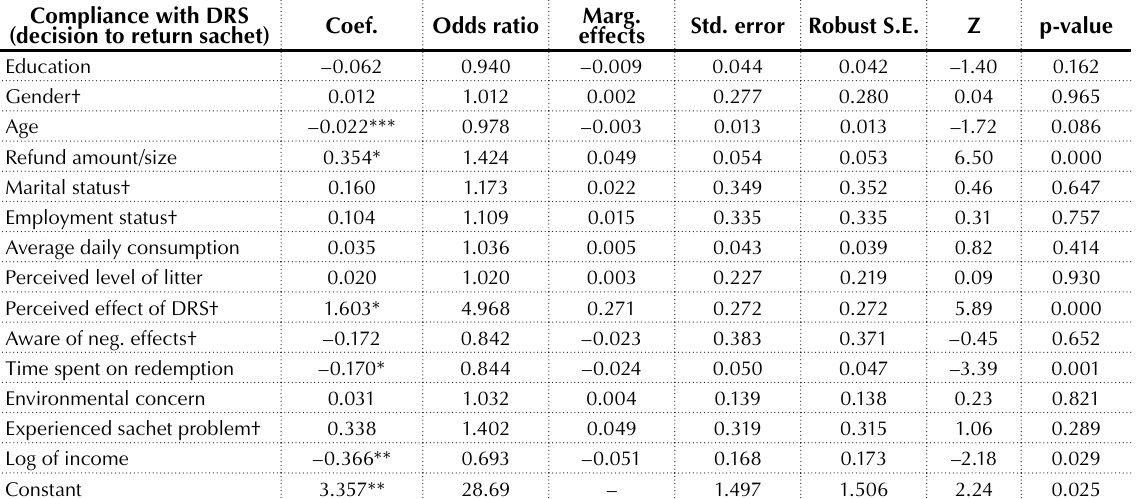
Table 7. Estimated binary logit model